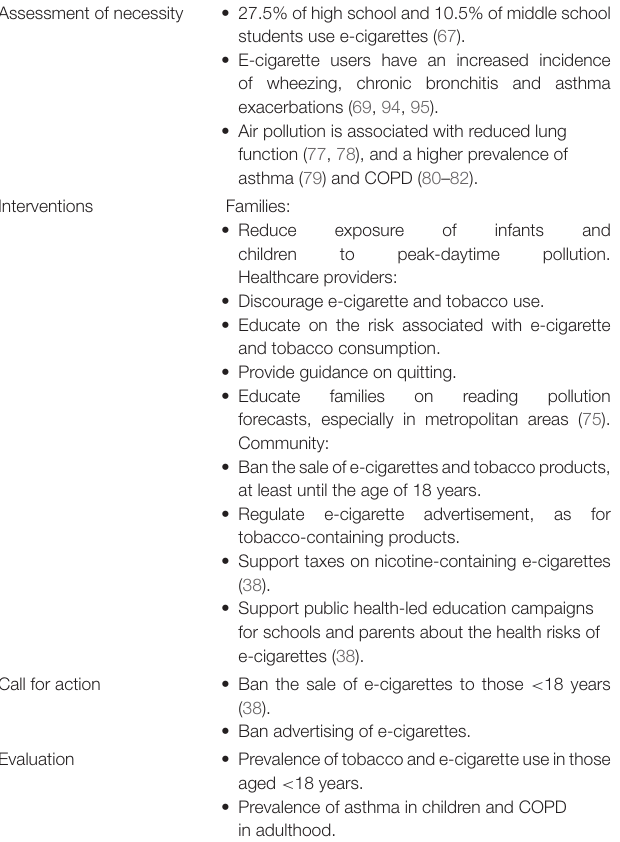
TABLE 4 | Mental and social